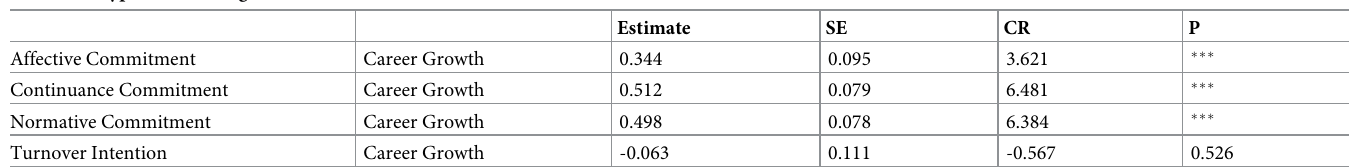
Table 11. Hypothesis testing.